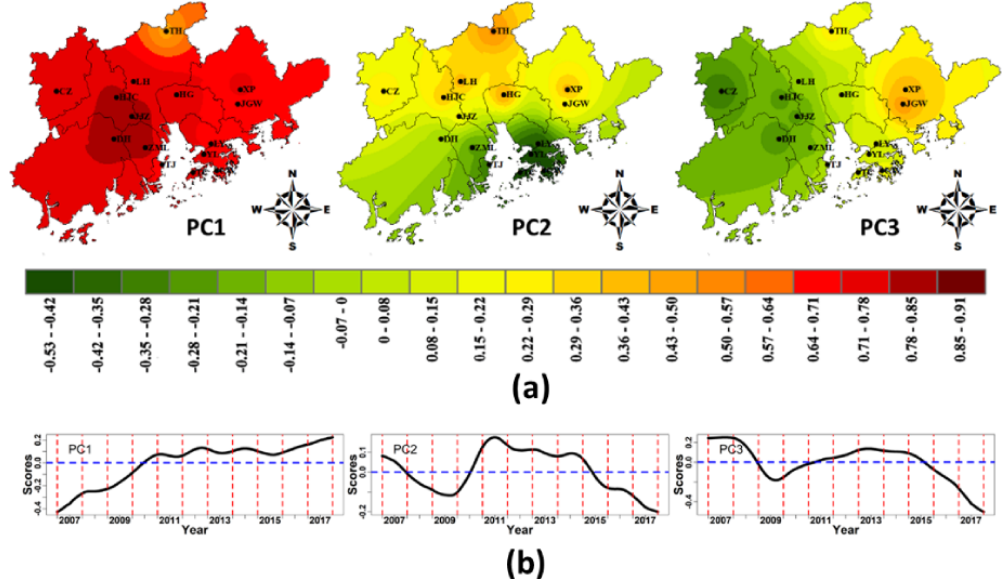
Figure 5. (a) The spatial distribution of principal component loadings in the Pearl River Delta, and (b) the long-term variation of principal component scores during the 2007–2017 period. PC1 reflects nonlocal emission impacts, whereas PC2 and PC3 refer to impacts from different local emissions.